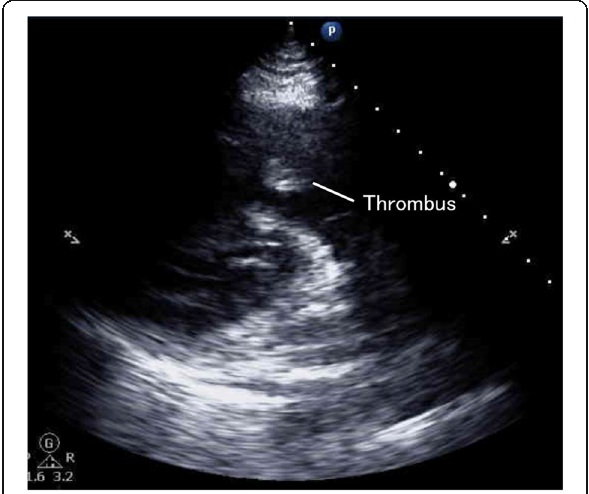
Fig. 3 Image showing massive thrombi removed from the pulmonary arteries